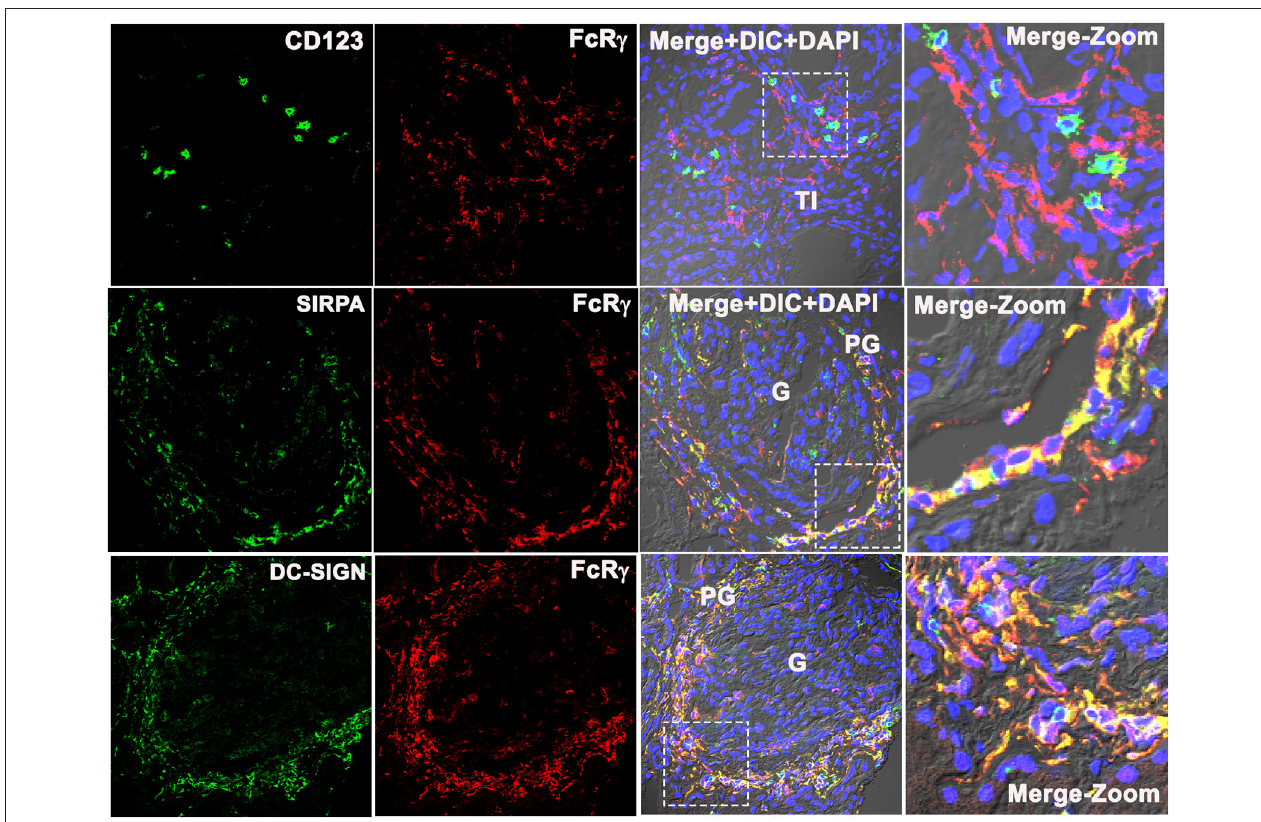
FIGURE 5 | Fc receptor gamma chain does not colocalize with plasmacytoid DC marker CD123, but colocalizes with monocyte-derived DC marker SIRPA and DC-SIGN in the human LN kidney. Three color confocal IF images that are representative of 3 human LN kidneys showing no colocalization of CD123 (green) with Fc receptor gamma chain (FcR γ ) (red) (top row) in the TI region of the kidney, but colocalize with monocyte-derived DC cell marker SIRP α (green) (middle row) and DC-SIGN (green) with FcR γ (red) (bottom row) in the PG region. The third column shows merged images of the first 2 columns plus DIC microscopy and DAPI staining of nuclei (blue). The fourth column shows the zoomed image of the third column highlighted using a dotted square.